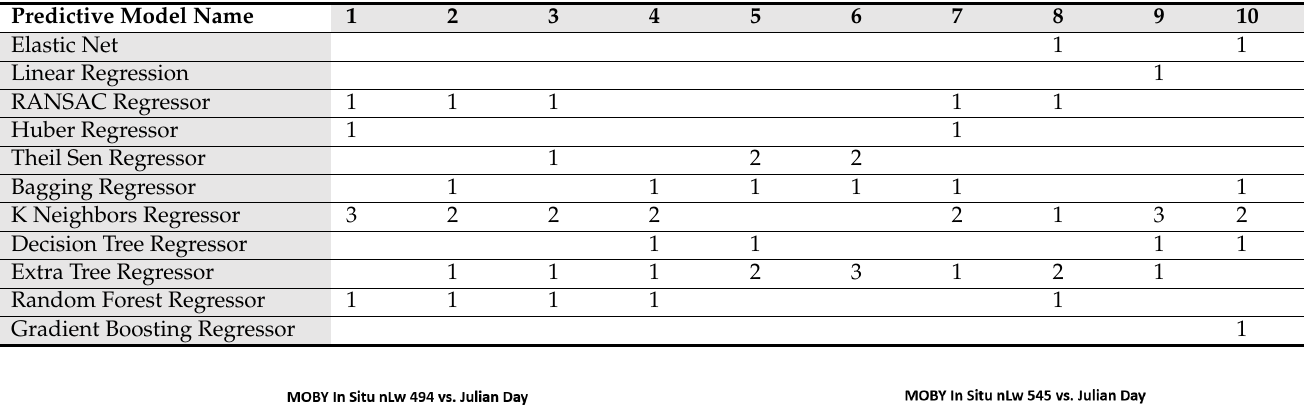
Table 2. Predictive model performance for various models based on Top 10 finishes as observed in Figure 7a–f. The numbers at the top of this table indicate which rank a model achieved if found within the Top 10 in any results observed within Figure 7a–f.